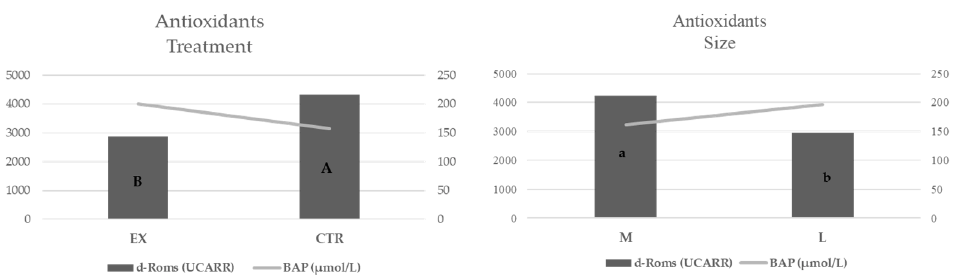
Figure 10. Oxidative status evaluated at the moment of pregnancy diagnosis in function of diets and size. EX: experimental group CTR: control group; d-ROMS: Reactive Oxygen Metabolites-derived compounds; BAP: Biological Antioxidant Potential. a, b: p < 0.05; A, B: p < 0.01.